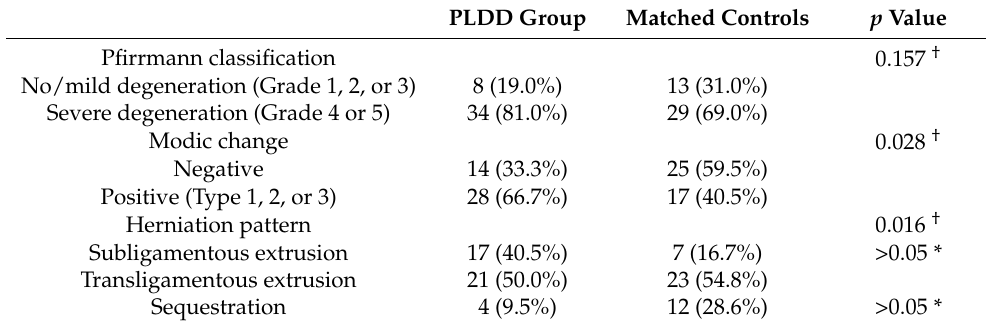
Table 3. Comparisons of radiographic analysis between the PLDD group and matched